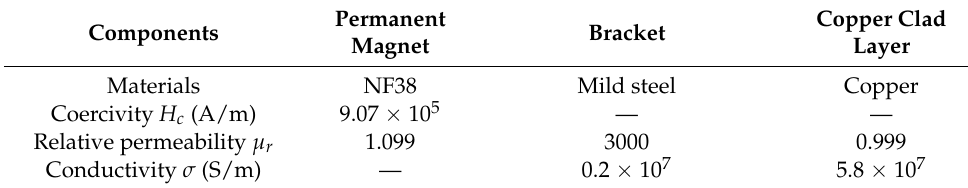
Table 5. Material property parameters of other components.